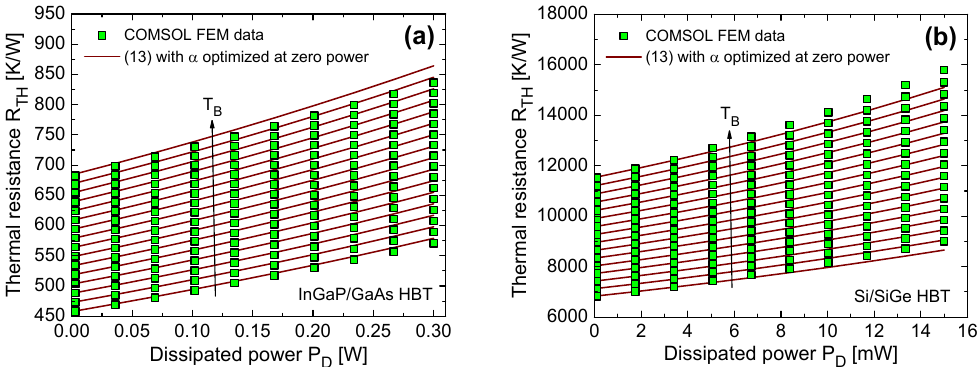
Figure 4. R TH vs. P D for T B spanning the range 300 to 450 K for ( a ) the InGaP/GaAs HBT and ( b ) the Si/SiGe HBT. COMSOL data (symbols) are compared with (13) where α was calibrated at very low dissipated power (solid brown lines), as shown in Figure 5.